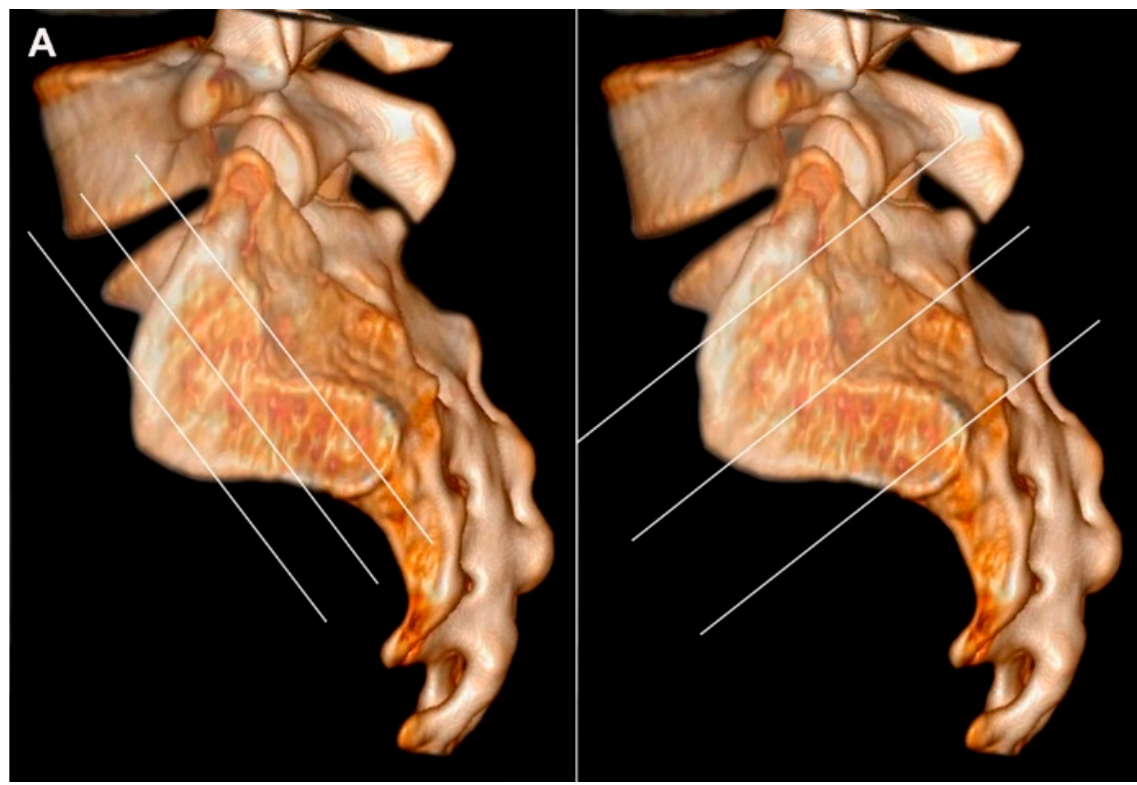
Figure 6. Recommended standard for a diagnostic SIJ MRI. The examination should include at least four sequences: A semi-coronal T1 and a cartilage sequence such as T1FS or a gradient echo sequence and STIR or T2FS in two perpendicular planes (semi-coronal and semi-axial) [34–36].